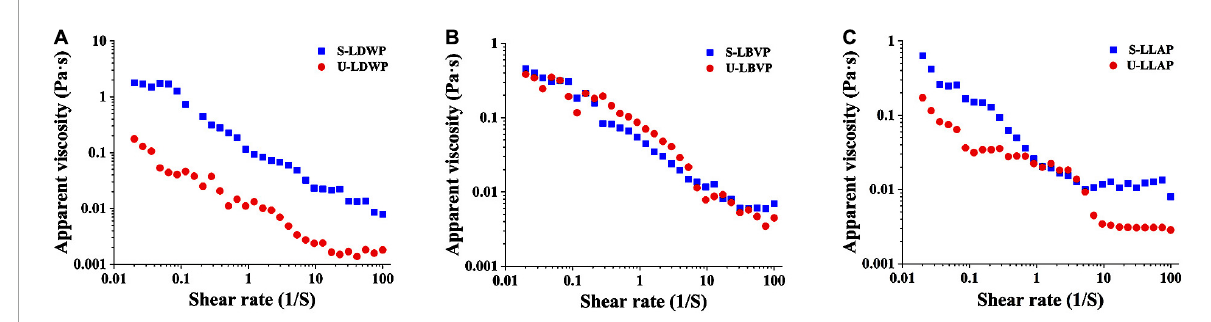
FIGURE5 The flow behavior of three lily polysaccharides extracted by different extraction methods. (A) Lilium davidii var. willmottiae polysaccharides (LDWP), (B) Lilium brownii var. viridulum polysaccharides (LBVP), (C) Lilium lancifolium polysaccharides